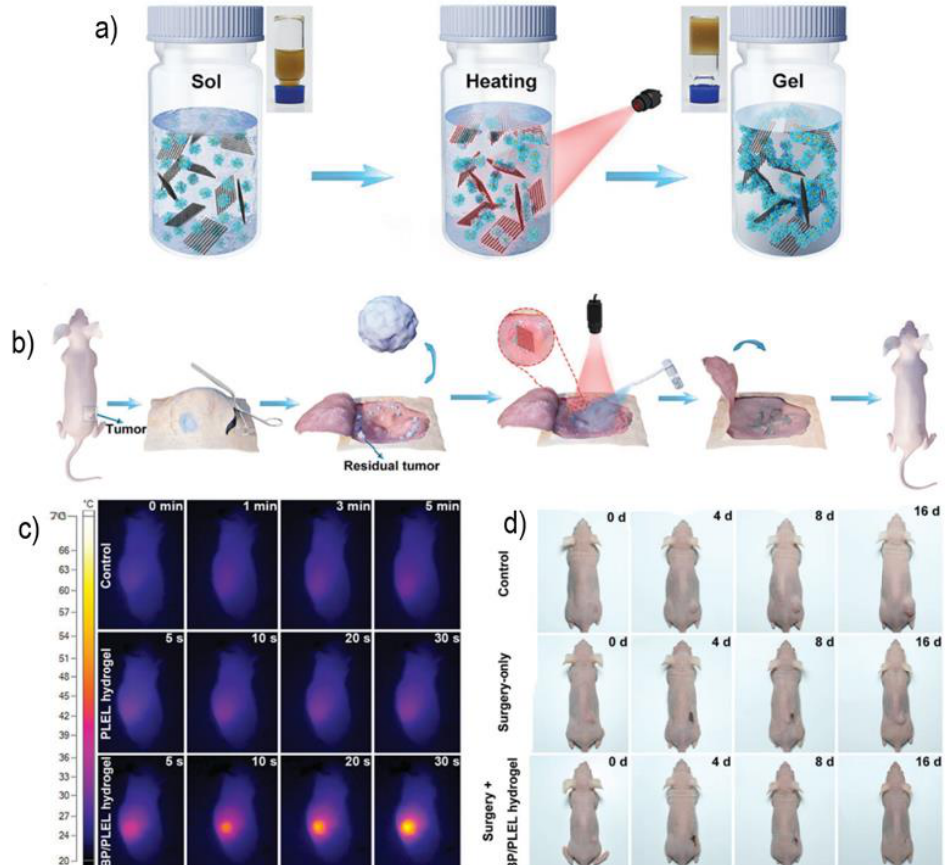
Figure 3. ( a ) Schematic of the BP/PLEL hydrogel gelation triggered by NIR radiation; ( b ) Schematic illustration of the post-surgical application of the BP/PLEL hydrogel. NIR induces gelation and promotes PTT of residual tumor while providing the site with an antibacterial platform; ( c ) time dependent thermographic map of the control, pristine PLEL, and BP/PLEL with NIR radiation; ( d ) photographs of the treatment progress throughout 16 days for control, surgery-only, and surgery + BP/PLEL with NIR hydrogel. No recurrence for the composite. Adapted from [73] © 2018 The Authors. Published by WILEY-VCH Verlag GmbH & Co. KGaA, Weinheim.